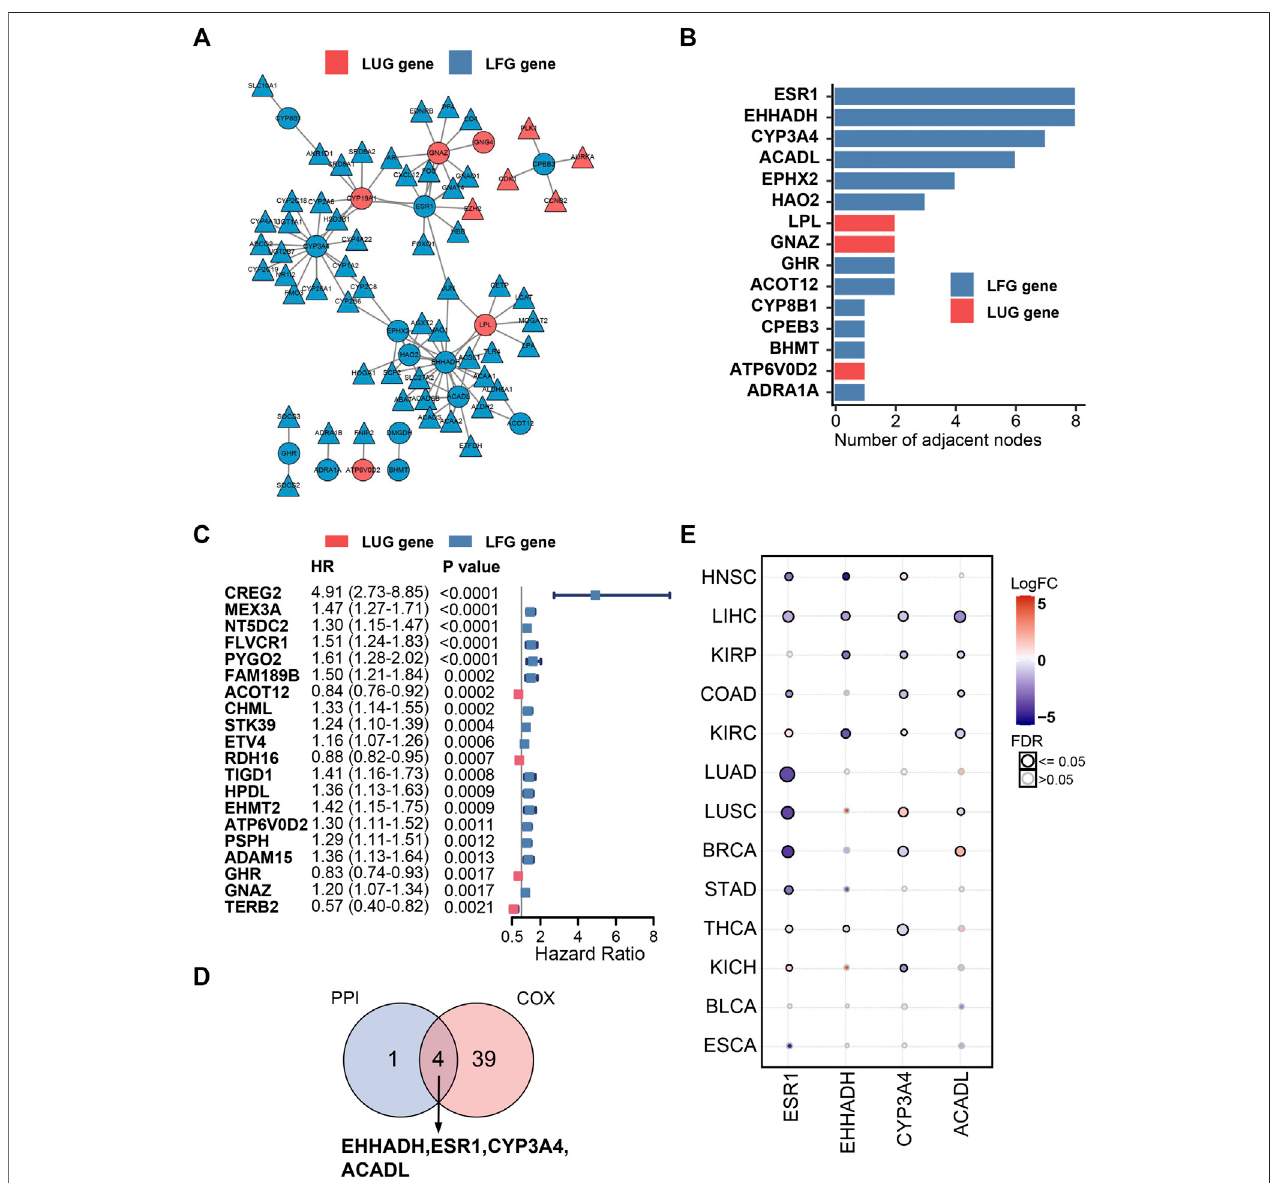
FIGURE8| PPInetworkandunivariateCoxregressionanalysis. (A) PPInetworkoftheLDGs. (B) Thetop15genesorderedbythenumberofnodes. (C) Univariate Cox regression analysis of LCGs. (D) Venn diagram displaying the key LCGs. (E) Pan-cancer analysis of key LCGs from GSCA database.